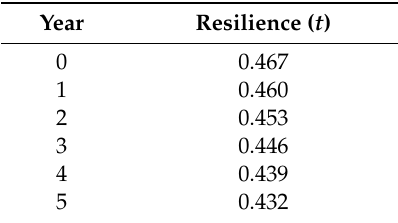
Table 8. Resilience of LWDN over the next five years.